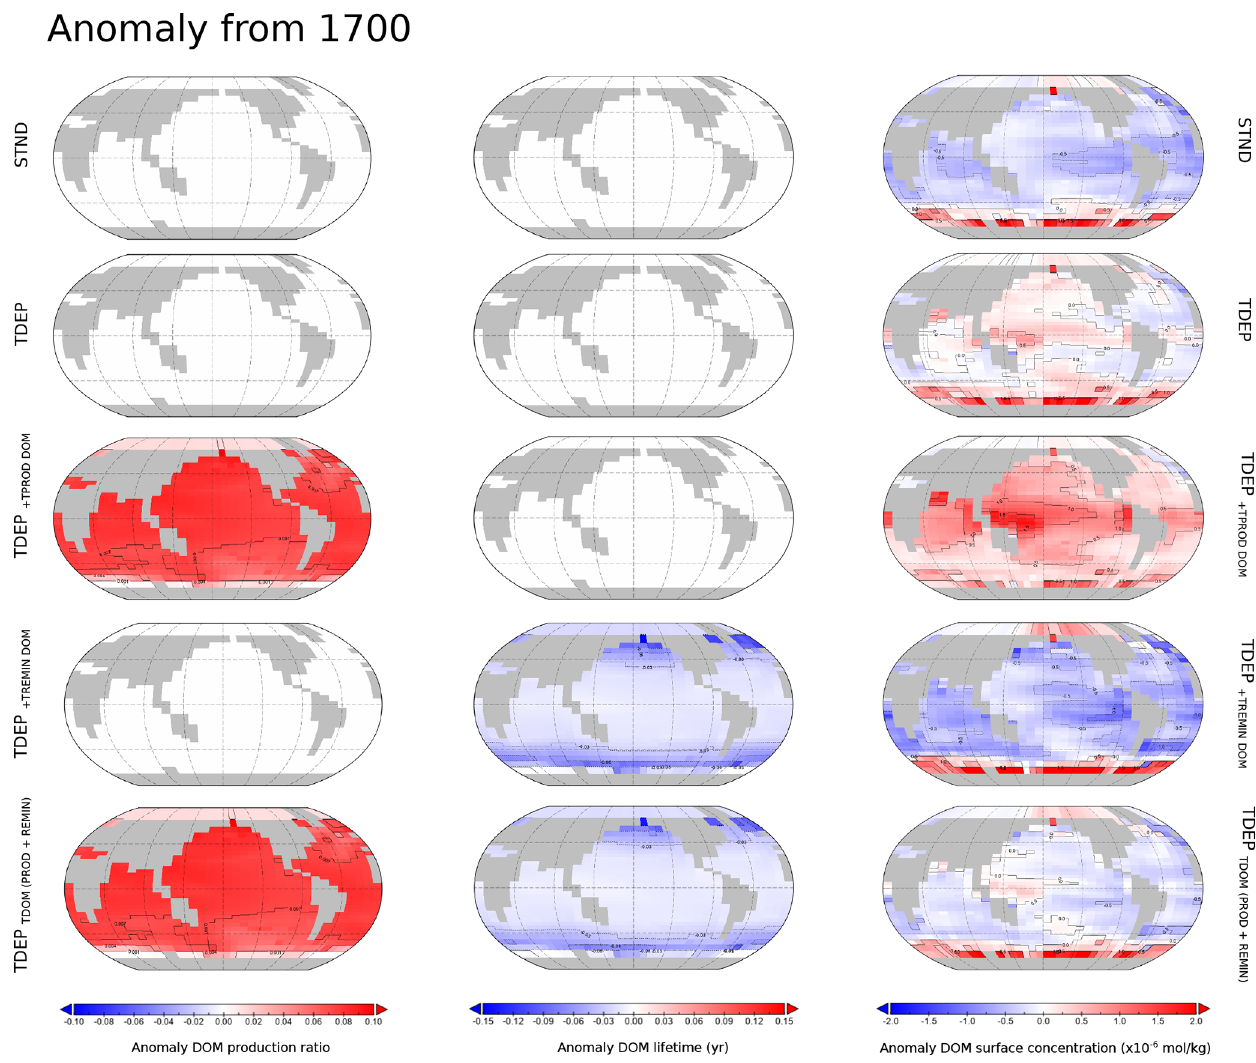
Figure A2. Anomalies for the present day against the year 1700 for surface ocean DOM production ratio, DOM lifetime, and DOM con- centration for the modelled present day. Labelled simulations include those discussed in the main text (STND, TDEP, and TDEP + TDOM ); TDEP + TDOM is labelled here as TDEP TDOM ( PROD + REMIN ) for clarity. Also mapped are DOM production and remineralisation temperature dependence separately applied as TDEP + TPRODDOM TDEP + TREMINDOM